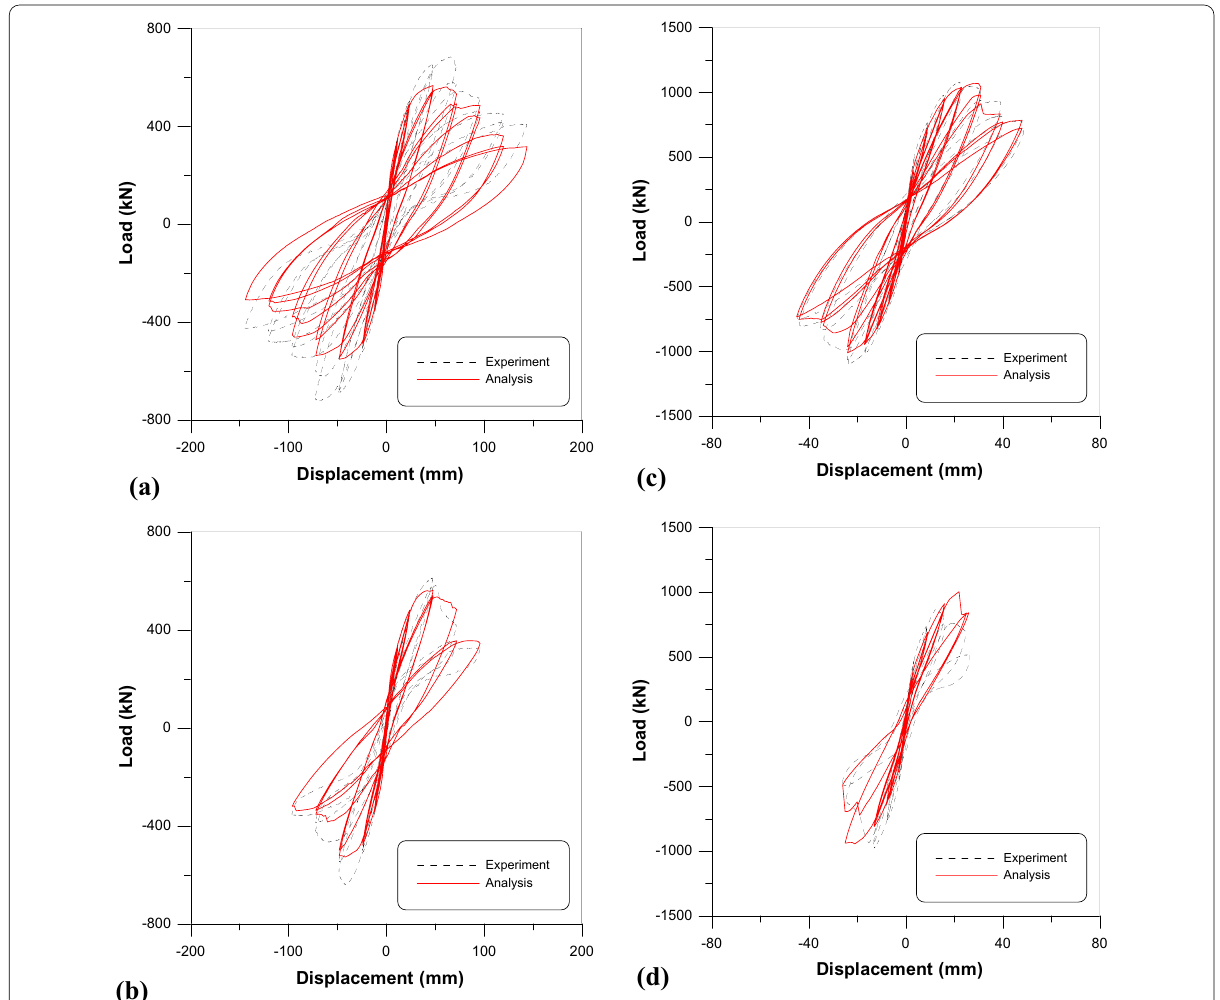
Fig. 11 Load–displacement curve for plane stress analysis: a Specimen NS‑HT2‑H‑L2, b Specimen NS‑HT2‑A‑L2, c Specimen FS‑H‑LS050 and d Specimen